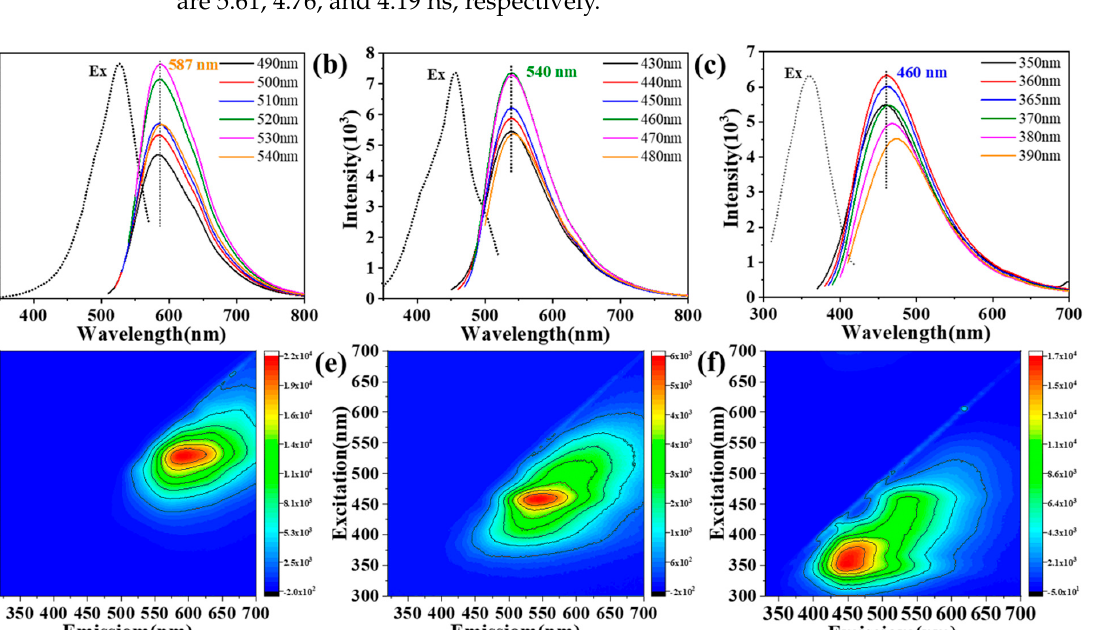
Figure 2. UV ‒ vis absorption spectra of the three CDs (0.1 mg/mL) in ethanol.